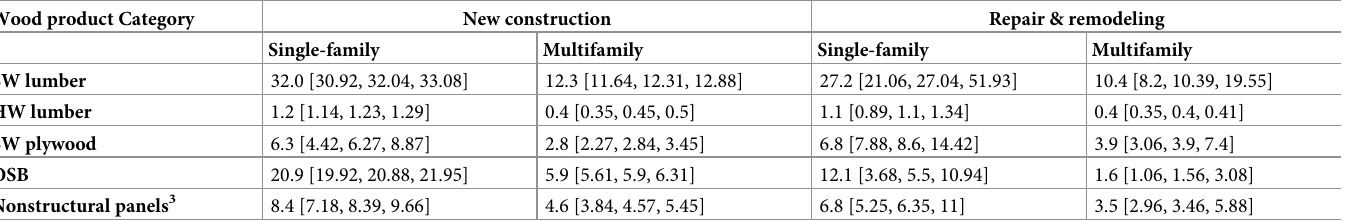
Table 2. Average 1 wood use intensity (m 3 /housing unit 2 ) by wood type, housing type, and usage type used to estimate carbon stored in wood products in use in resi- dential units (source: [35]).